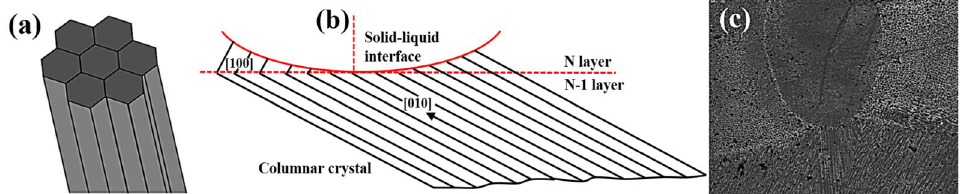
Figure 16 a Illustrations of the metastable three-dimensional columnar microstructure; b Schematic diagram and c SEM photograph of the crystal growth direction between two adjacent